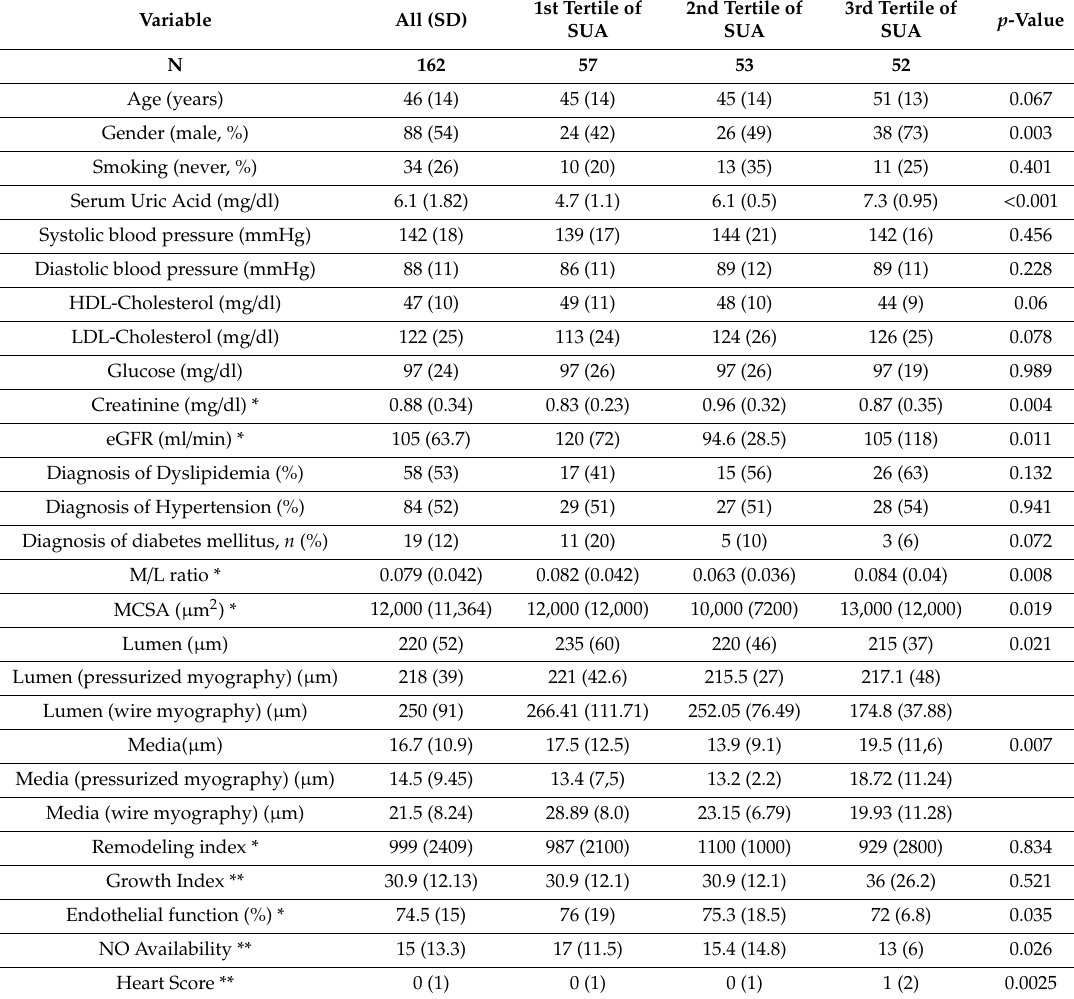
Table 1. Characteristics of the population stratified by tertiles of serum uric acid (SUA).